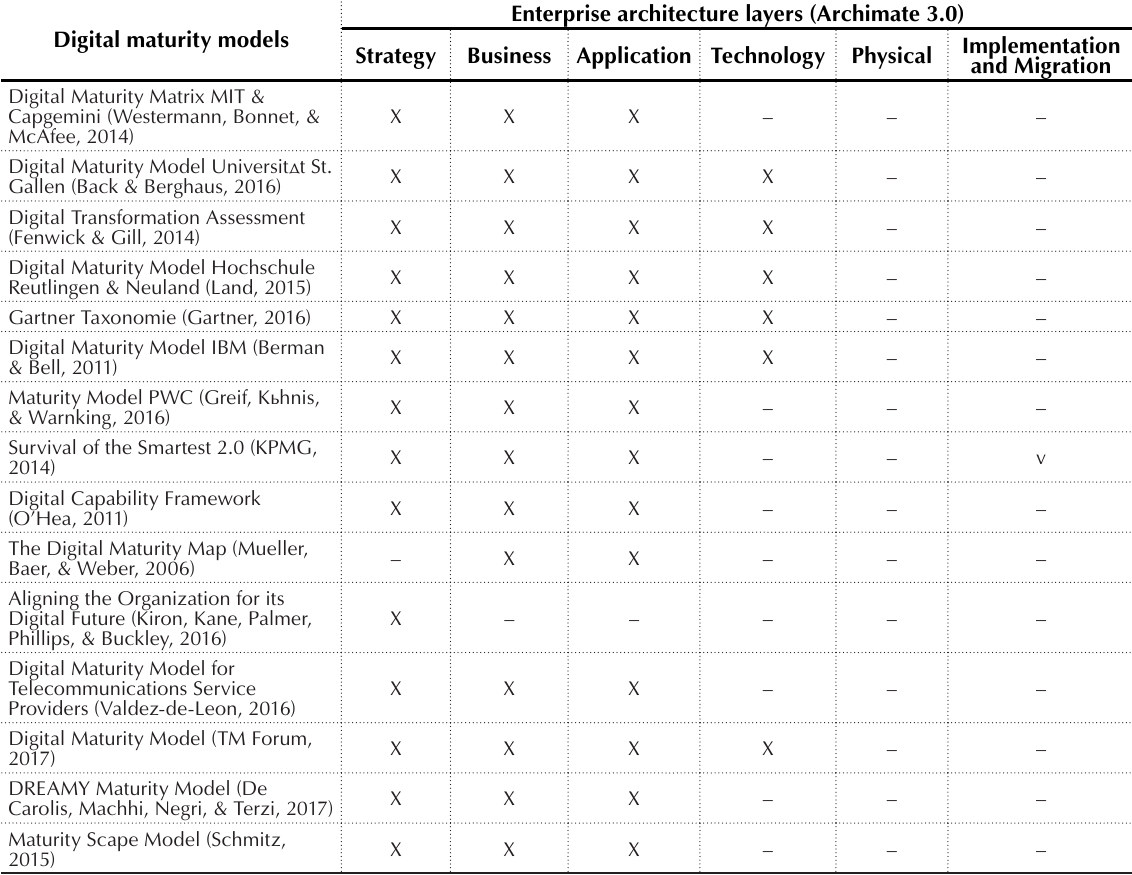
Table 2. Mapping of digital maturity models to enterprise architecture